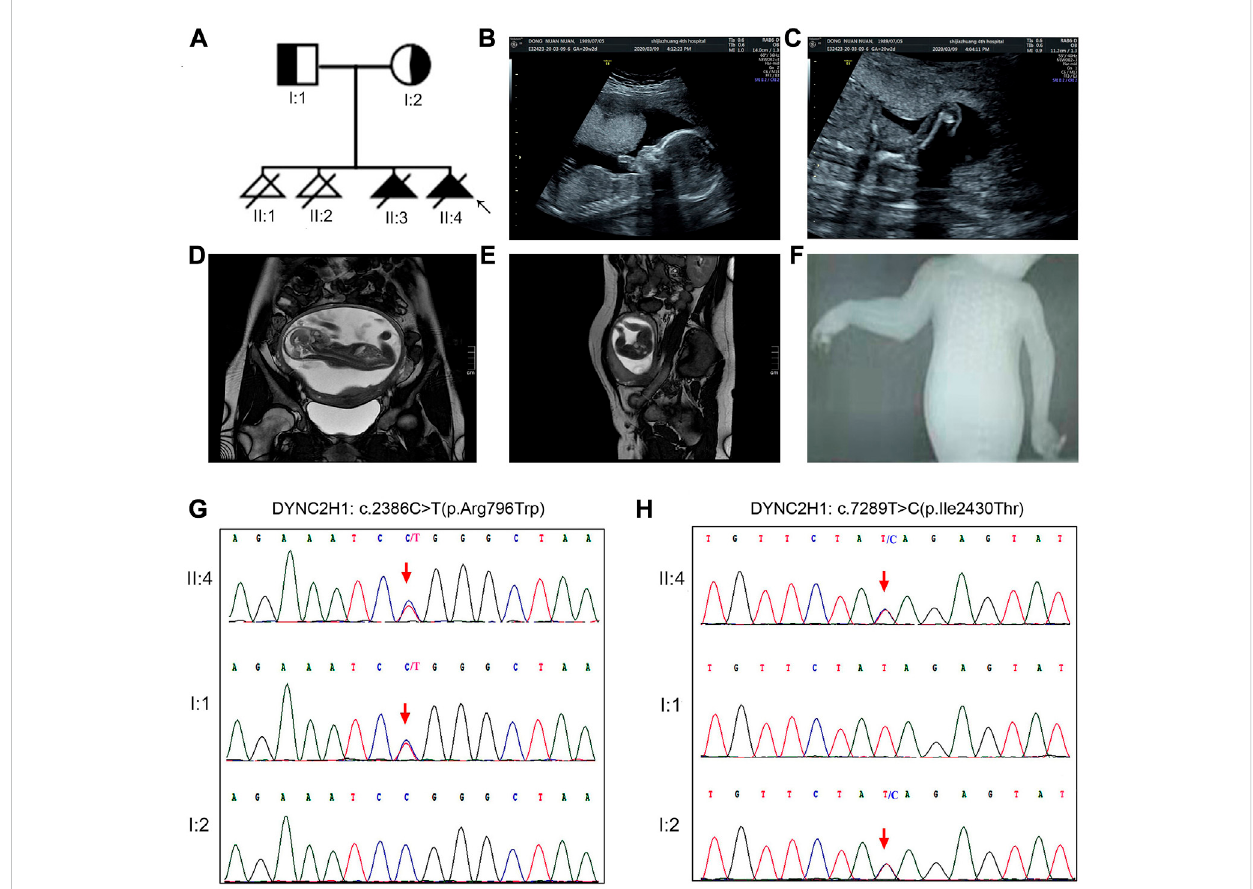
FIGURE 1 Theclinical fi ndingsandgeneticvariationincase1. (A) PedigreediagramofthefamilywithSTRD3. (B – E) UltrasonographicandMRIindicationsofthe fetusincase1:thefetushadextremelyshortlimbsandasmall,narrowthorax. (F) X-rayindicationsofthefetusincase1:thefetushadanarrowthoraxand short limbs, but no polydactyly. (G, H) The genetic variation identi fi ed in this case: proband 1 (II-4 in Case 1) carried two missense variants, namely c.2386C > T (p.Arg796Trp) and c.7289T > C (p.Ile2430Thr). Validation with Sanger sequencing demonstrated that the variants these probands carried were all inherited from their asymptomatic heterozygous carrier